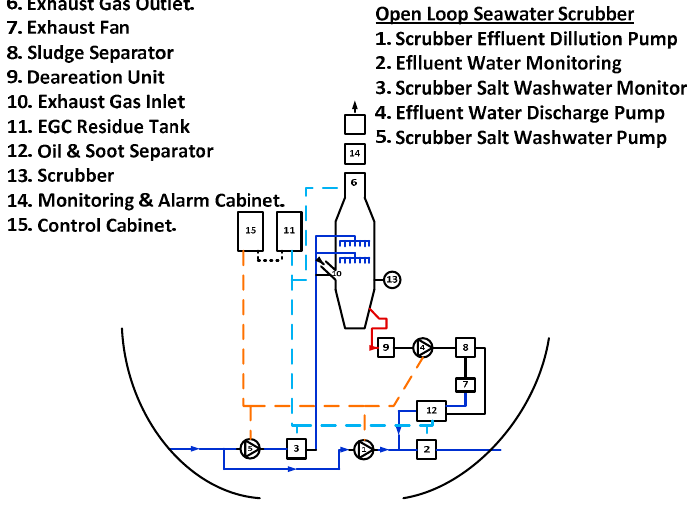
Figure 1. Schematic view of the on-board installation of an open-loop wet SO x scrubbing system operating with seawater. (Figure was genuinely generated using data from ref. [29]).